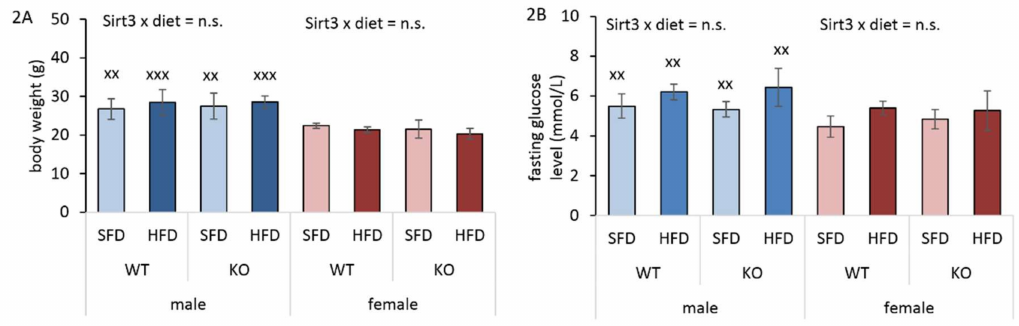
Figure 2. Body weight and fasting glucose level in Sirt3 wild-type (WT) and knockout (KO) mice fed with a standard fat diet (SFD) or a high fat diet (HFD) for 10 weeks. ( A ) A graphical display of body weight. Males: no changes. Females: no changes. Males vs. females: SFD-fed mice ( xx p < 0.01); HFD-fed mice ( xxx p < 0.001). ( B ) A graphical display of fasting glucose levels. Males: no changes. Females: no changes. Males vs. females: xx p < 0.01. The data are shown as mean ± SD. n = 6 per